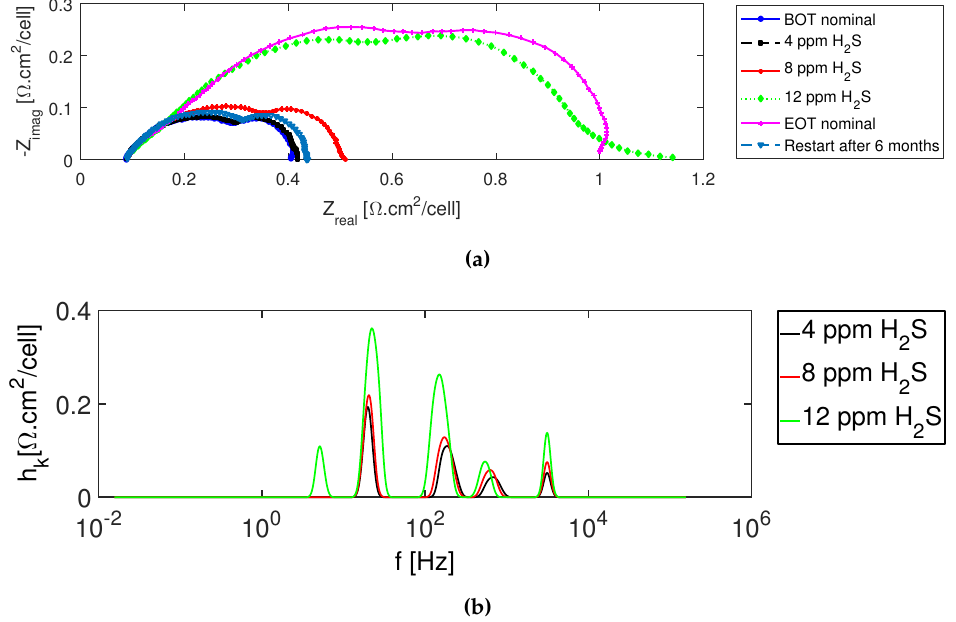
Figure 7. Sulfur poisoning at 40 A: ( a ) impedance spectra; ( b ) DRT